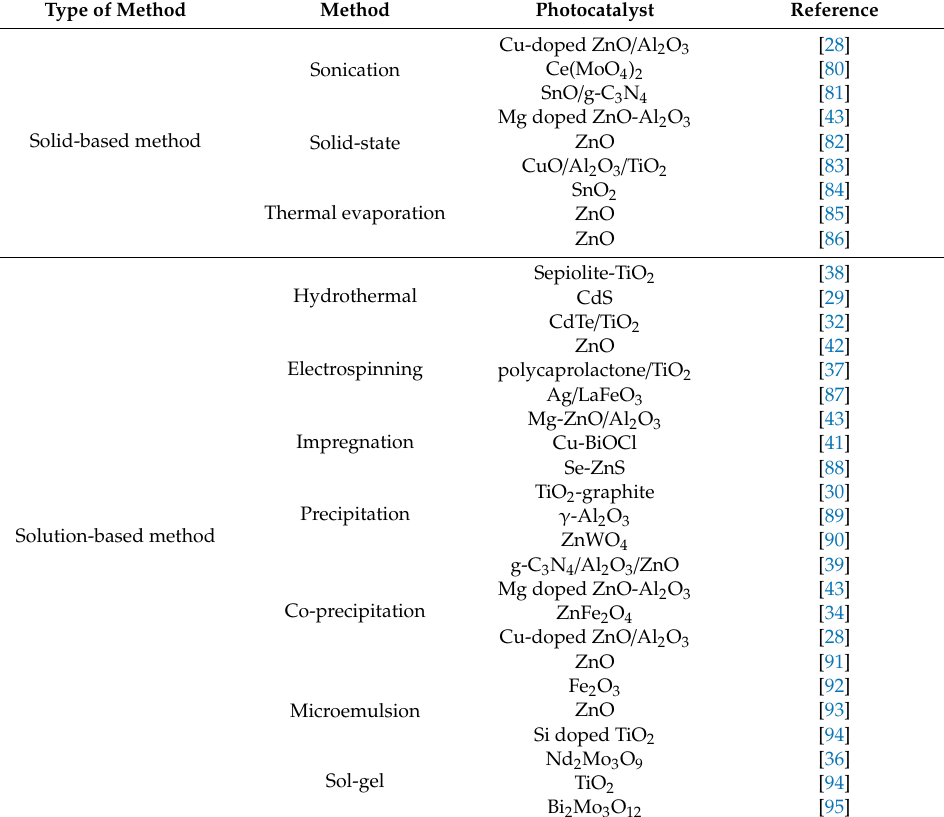
Table 3. Published preparation methods for